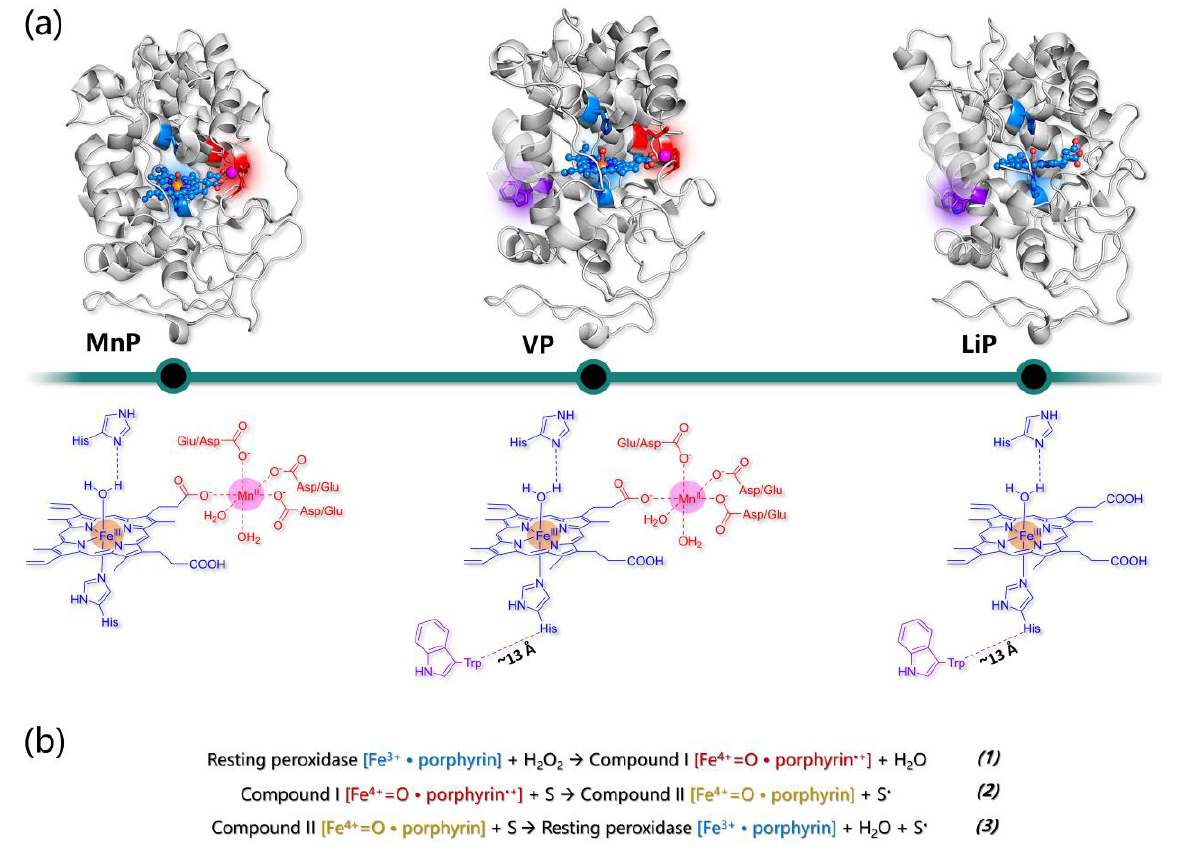
Figure 9. ( a ) The crystal structure of MnP found in Phanerodontia chrysosporium (PDB: 1YYD), VP found in Pleurotus eryngii (PDB: 2BOQ), and LiP found in Phanerodontia chrysosporium (PDB: 1B82). For each enzyme, a 2D representation of the catalytically active sites is reported. ( b ) Scheme of the catalytic cycle reactions of class-II heme peroxidases (S represents a generic